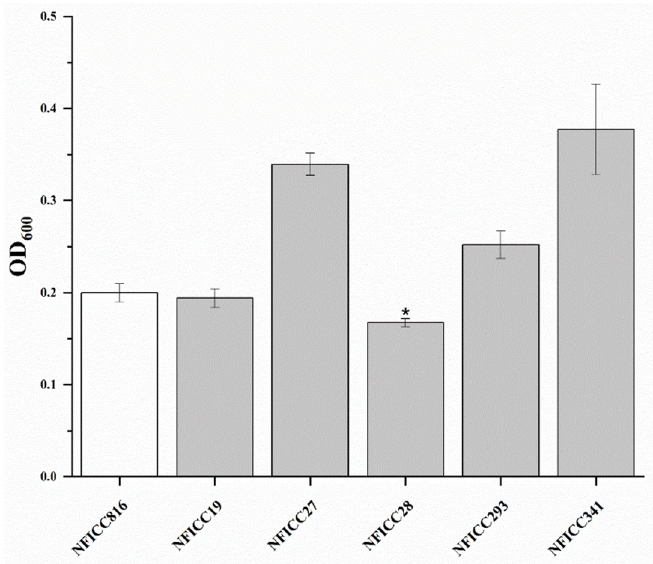
Figure 2. Antibacterial activity of the selected LAB’s cell-free supernatant in Bread Media (BM) against spoilage agents B. thuringensis NFICC816. One-tail t -test was performed on the obtained triplicates comparing OD 600 value after 48 h growth of NFICC816 in BM and the same pathogens challenged with CFS of L. plantarum (NFICC19, 27, and 293) and P. pentosaceus (NFICC341). The mean value of one treated sample of Lc. citreum (NFICC28) was significantly lower than the control sample (untreated sample), while the other samples respected the null hypothesis; t(2) = − 2.92 and p = 0.05. Bars with * are significantly different.